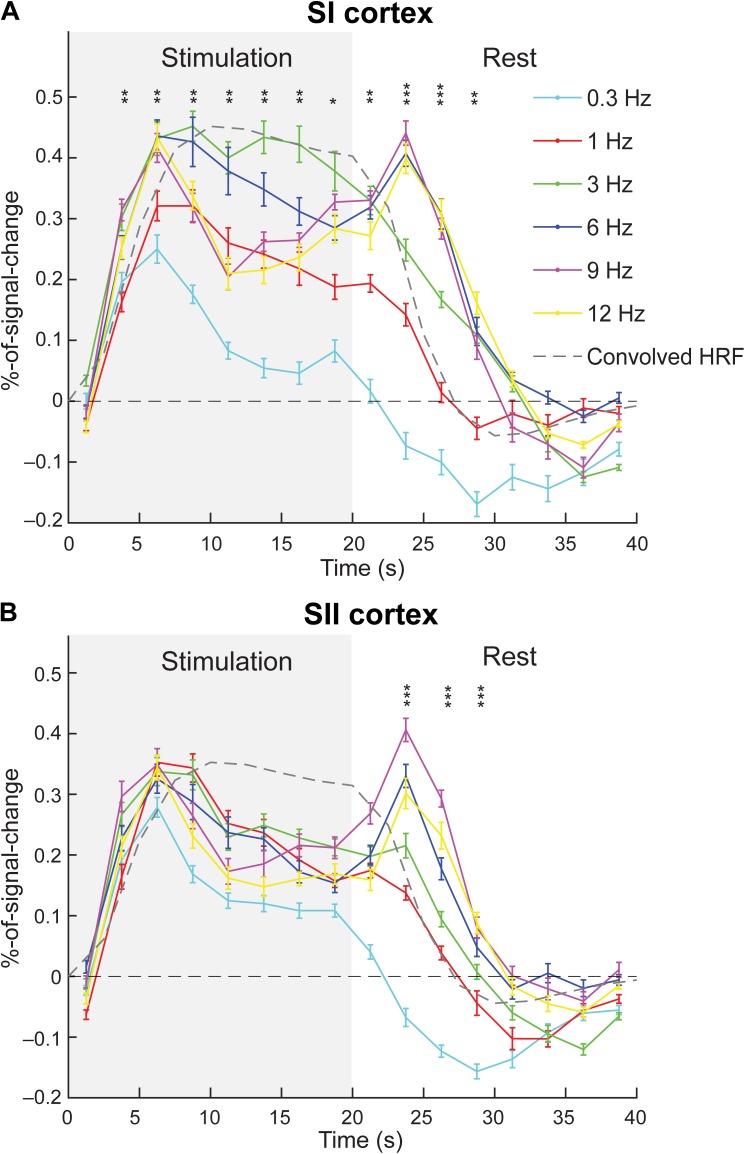
Group-averaged hemodynamic time-courses. The time-course of each movement frequency (solid lines) is shown for SI (A) and SII (B) cortex. Gray dashed line represents convolved canonical HRF. Gray background represents the stimulation (movement) period. The error bars represent standard errors. The asterisks represent significant differences between the frequencies at a given time points (∗p < 0.05, ∗∗p < 0.01, and ∗∗∗p < 0.001).